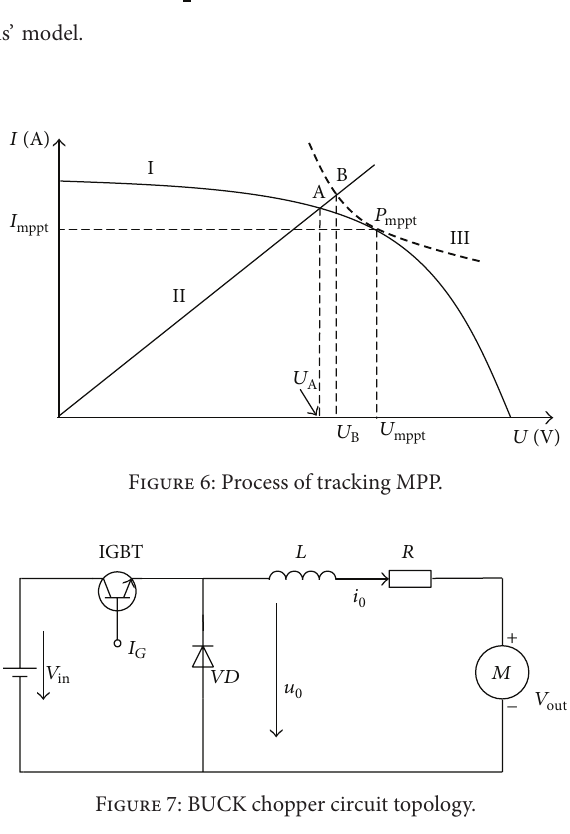
Figure 4: PV cells’ model.